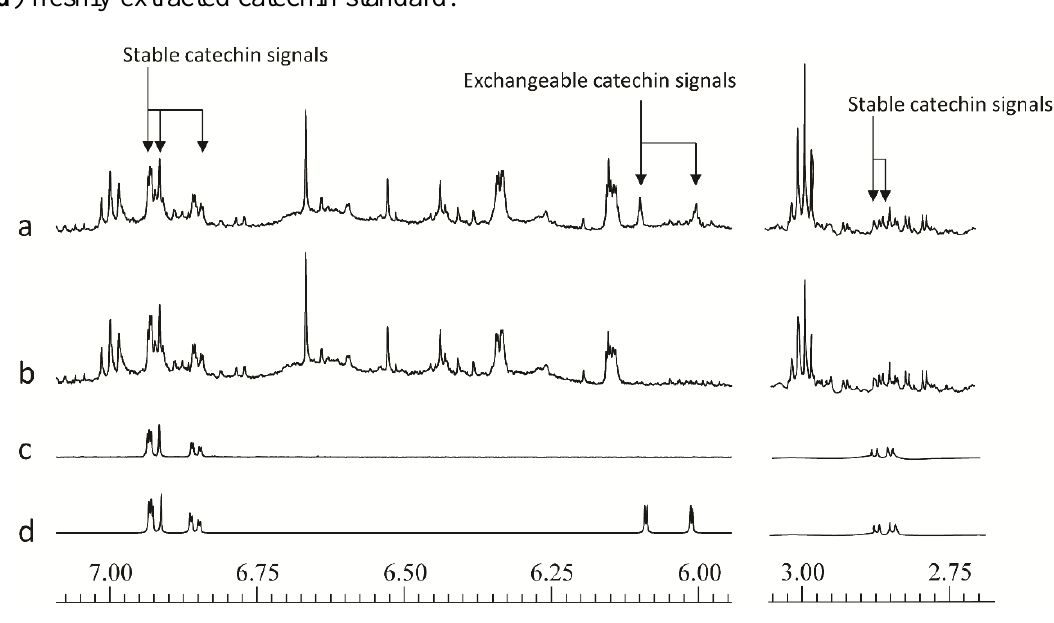
Figure 3. 600 MHz 1D 1 H-NMR spectral regions from δ7.075–5.95 and δ3.05–2.70